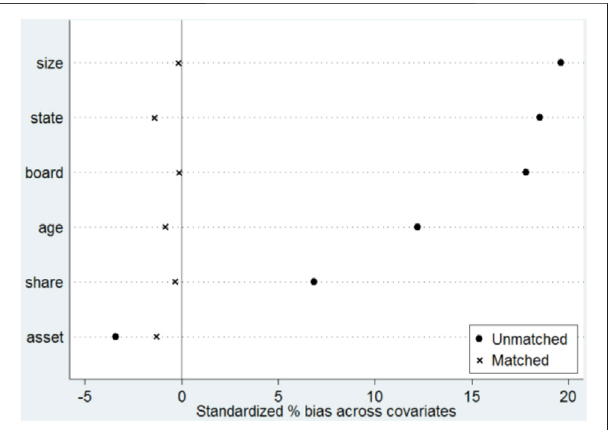
FIGURE 1 | PSM parallelism hypothesis test results (single column